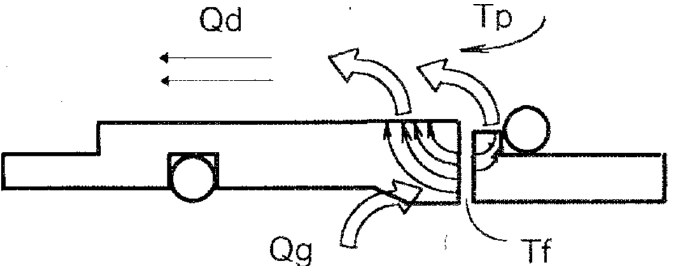
Figure 1. Temperature flows from the MFS interface [31], where Qd—dissipated heat; Qg—gener- ated heat; Tf—temperature in the interface; Tp—temperature of the sealed fluid heat; Tf—temperature in the interface; Tp—temperature of the sealed